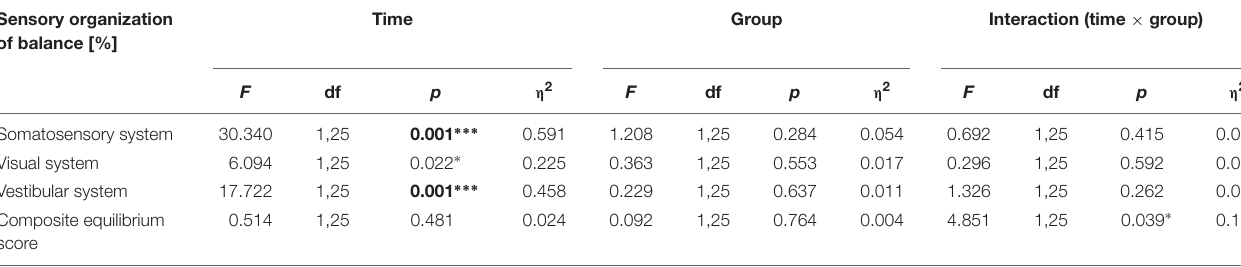
TABLE 3 | Statistical values of repeated-measures ANOVAs for sensory organization of balance. Sensory organization Time Group Interaction (time × group) of balance [%]